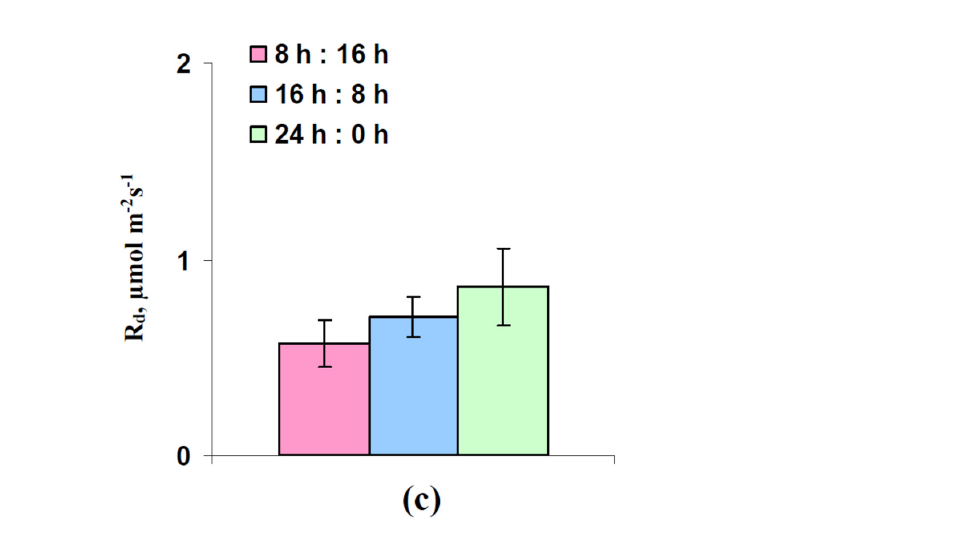
Figure 7. Influence of photoperiod on rate of the dark respiration rate (R d ) after 18 days ( a ), 25 days ( b ), and 32 days ( c ) lettuce cultivation ( n = 6). “8 h:16 h” is 8 h (light):16 h (dark), “16 h:8 h” is 16 h (light):8 h (dark), and “24 h:0 h” is 24 h (light):0 h (dark). Significant differences from control plants cultivated under 16 h (light):8 h (dark) were absent.